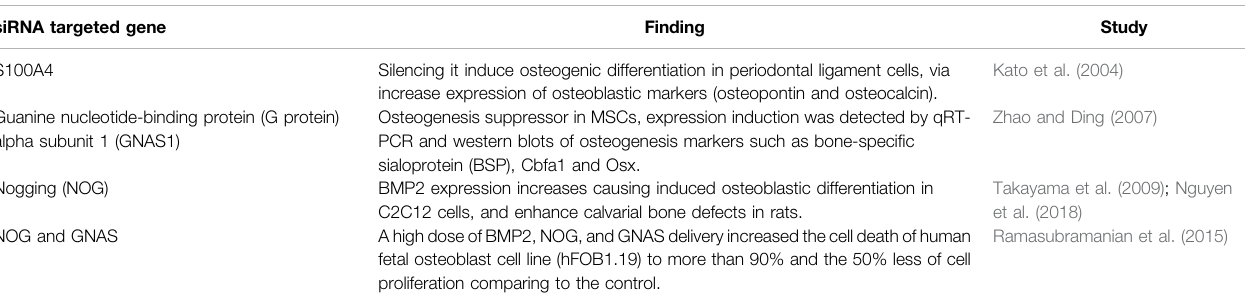
TABLE 4 | Examples of genes targeted by siRNA used to understand osteogenesis. siRNA targeted gene